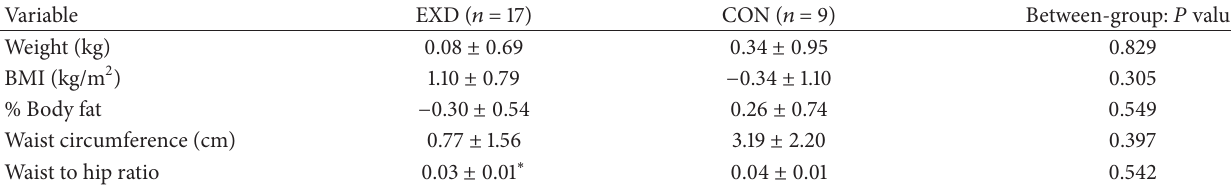
Table 3: Anthropometric changes with the 12-week intervention between the EXD and CON